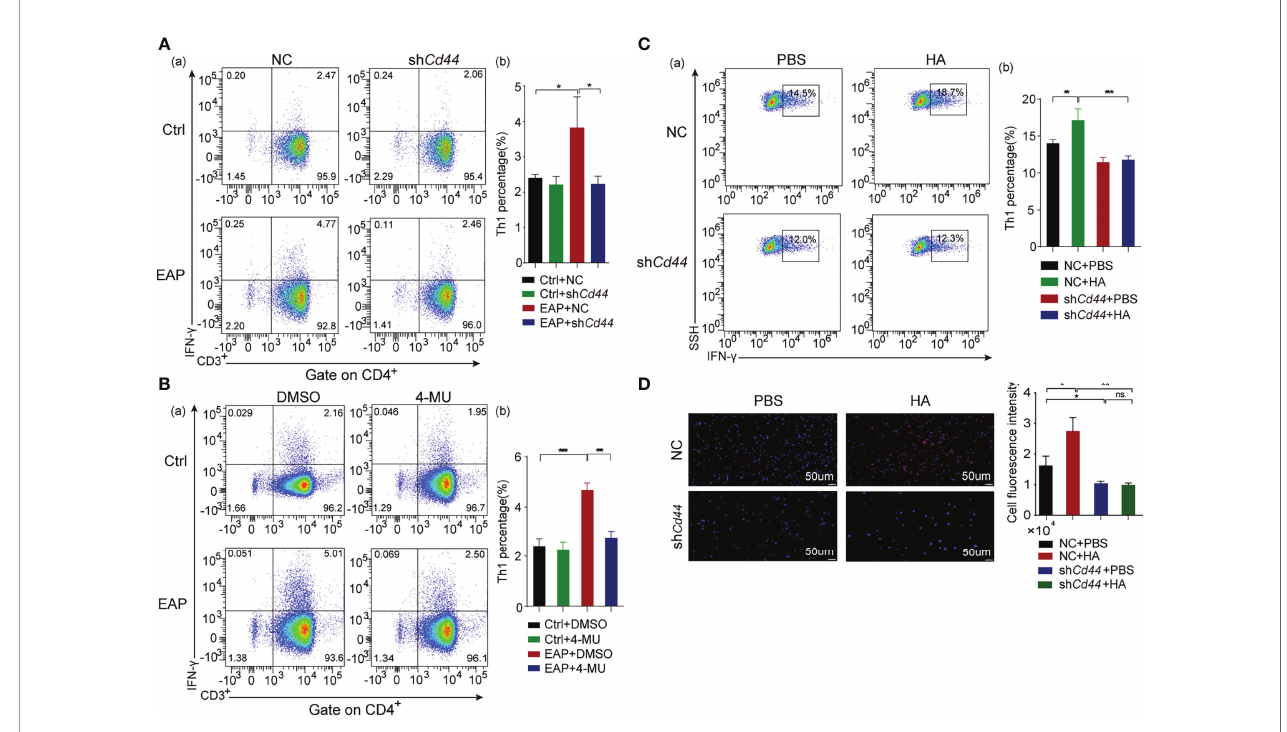
FIGURE 3 | HA/CD44 axis plays an important effect on the occurrence of EAP by promoting Th1 cells differentiation. (A) The percentage of Th1 cells in splenic lymphocytes of immunized mice from the Ctrl + NC, the Ctrl + sh Cd44 , the EAP + NC, and the EAP + sh Cd44 groups by fl ow cytometry (a, cell fl ow cytometry diagram and b, corresponding data analysis according to data in a). (B) The percentage of Th1 cells in splenic lymphocytes of immunized mice from the Ctrl + DMSO, the Ctrl + 4-MU, the EAP + DMSO, and the EAP + 4-MU groups by fl ow cytometry (a, cell fl ow cytometry diagram and b, corresponding data analysis according to data in a). (C) The differentiation ratio of Th1 cells in the in vitro differentiation experiment by fl ow cytometry (a, cell fl ow cytometry diagram and b, corresponding data analysis according to data in a). (D) The differentiation ratio of Th1 cells (IFN- g ) in the in vitro differentiation experiment by immuno fl uorescence. ns, Not Signi fi cant. ***p < 0.001, **p < 0.01, *p <